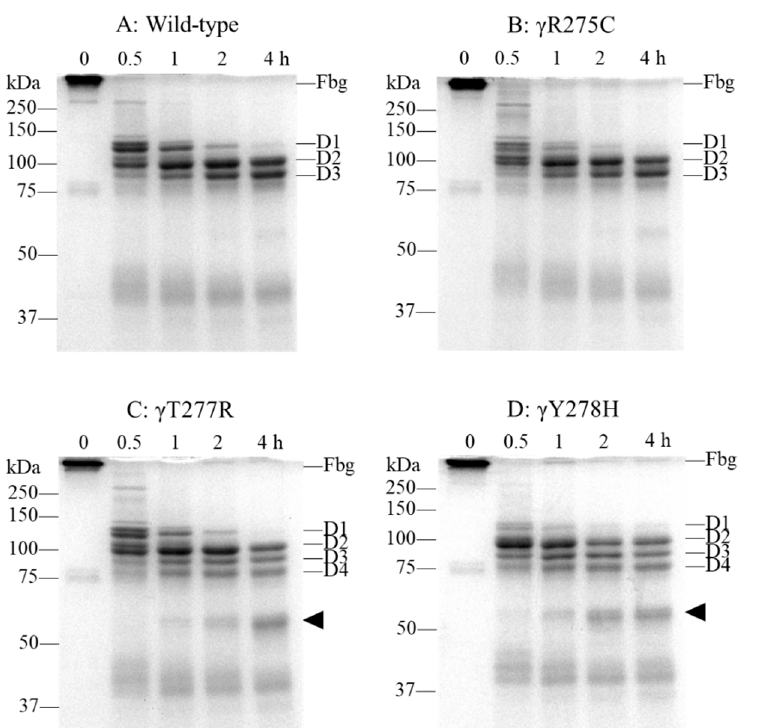
Figure 4. Fibrinogen degradation assay with plasmin. Recombinant fibrinogens (0.30 mg/mL) in HBS buffer containing 5 mM EDTA were incubated with 0.18 U/mL plasmin for 0–4 h at 37 °C. The fragments were analyzed by 10% SDS-PAGE and with Coomassie brilliant blue (CBB) staining. Fibrinogen (Fbg), fragments D1, D2, D3, and D4, and lower molecular weight fragment ( ◀ ) are indicated on the right side of each panel. ( A ) wild type, ( B ) γ R275C, ( C ) γ T277R, ( D ) γ Y278H.